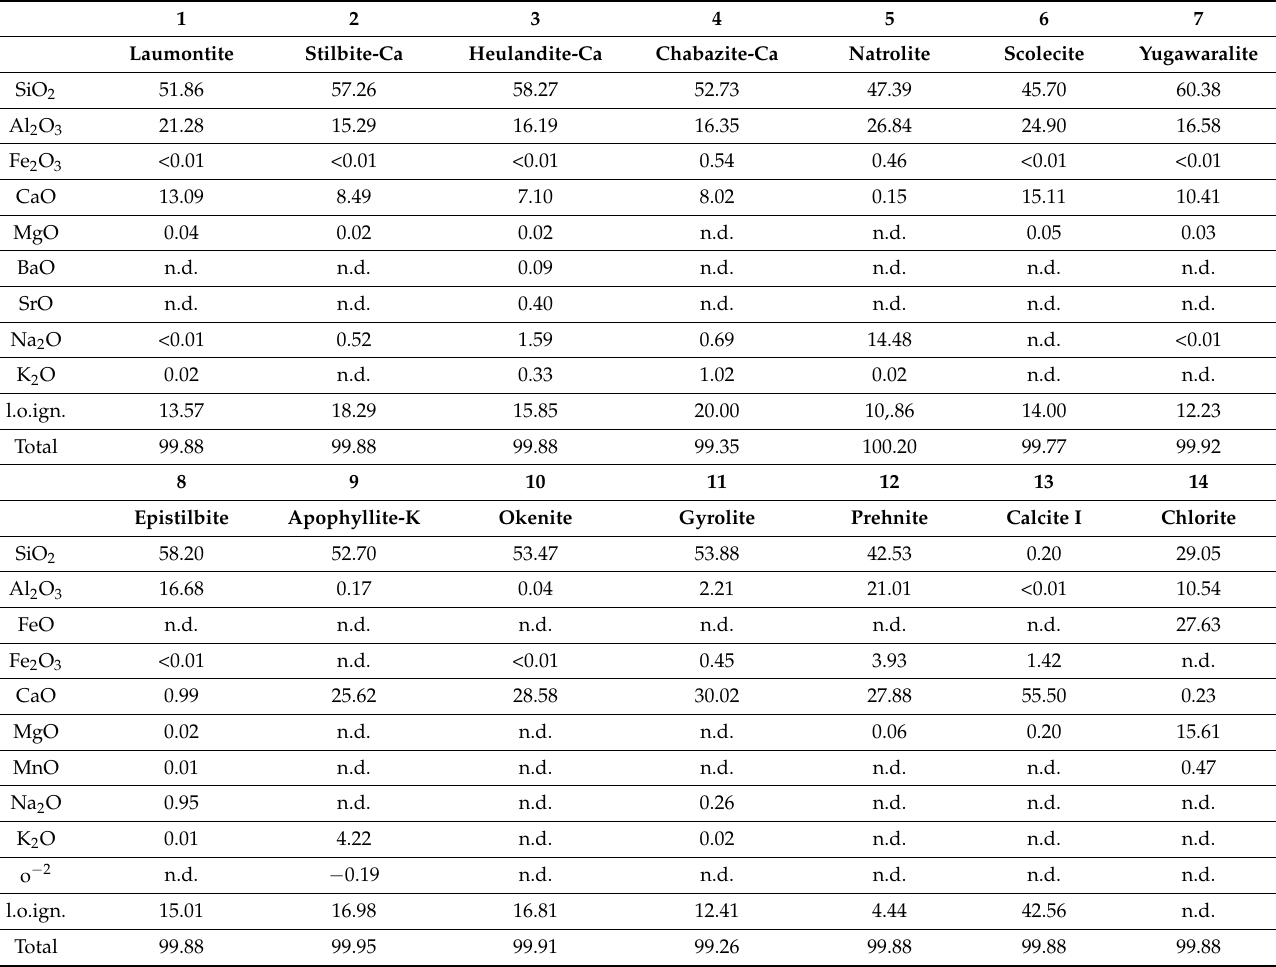
Table 2. Chemical composition (wt.%) of the most common secondary minerals from Salsette